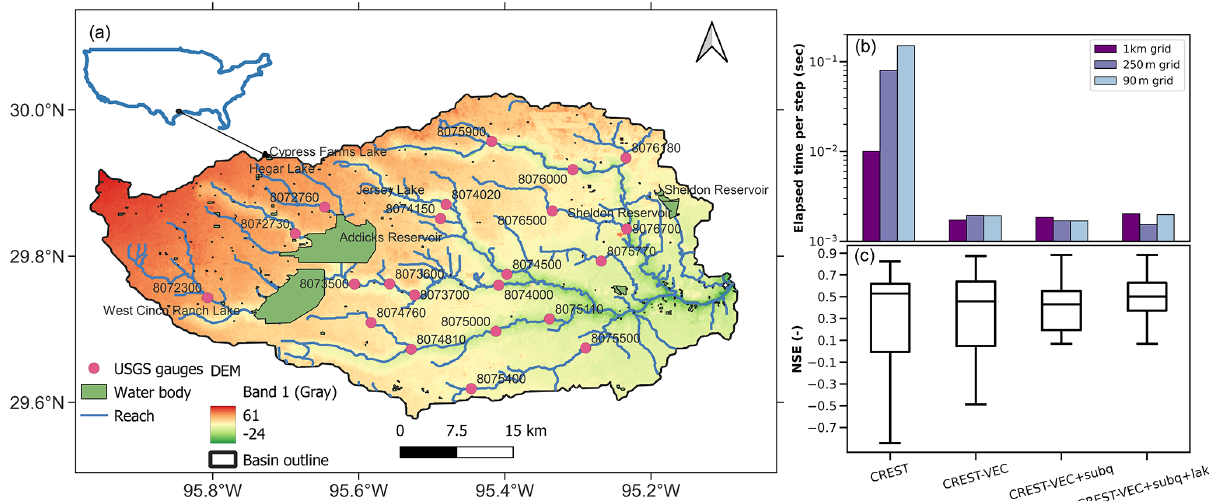
Figure 3. (a) Map of the study area (Houston region) showing river networks and water bodies. (b) Computation time per step for CREST at three resolutions and CREST-VEC model at four configurations on the x axis. (c) Nash–Sutcliffe efficiency values for CREST and CREST- VEC model.